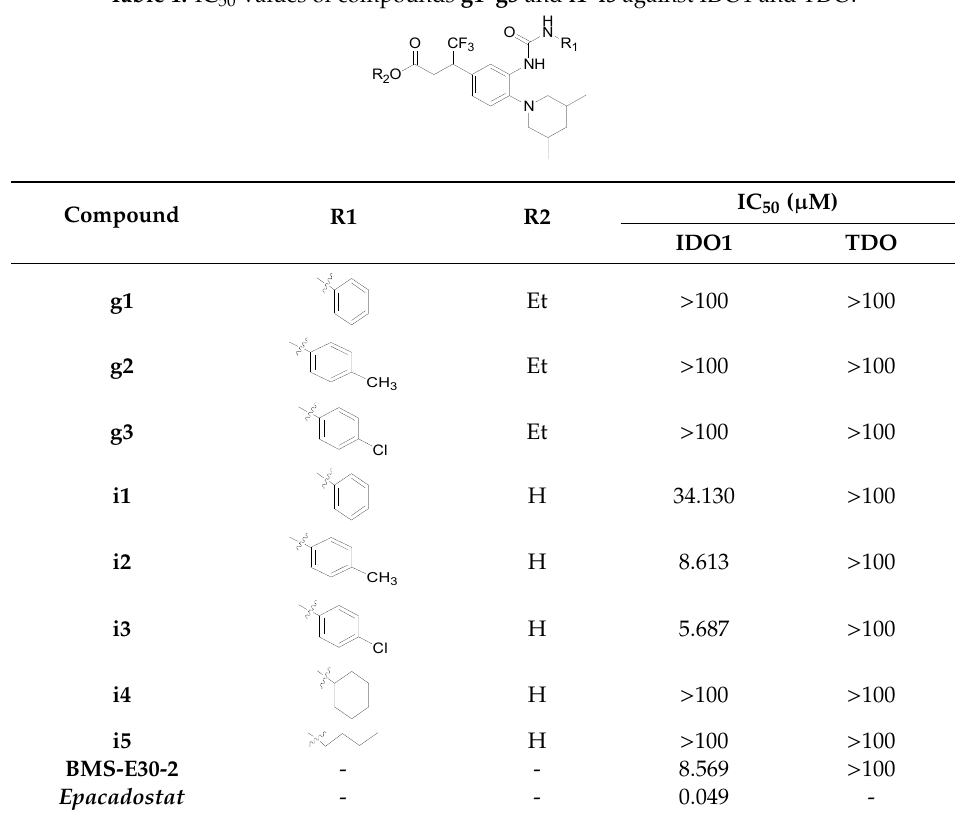
Table 1. IC 50 values of compounds g1 – g3 and i1 – i5 against IDO1 and TDO.